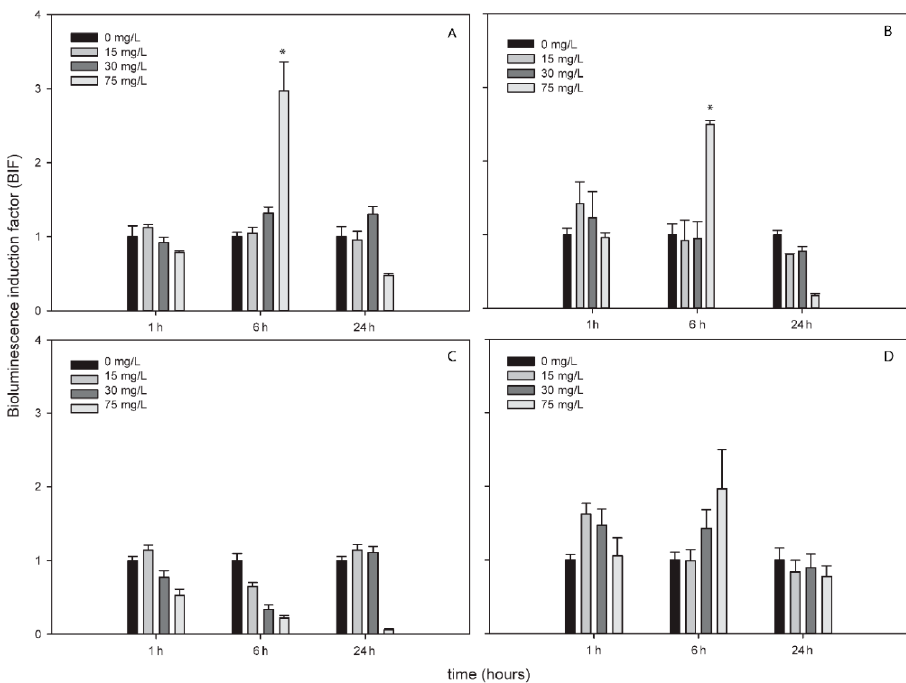
Figure 3 . Bioluminescence induction of ROS-detecting Nostoc sp PCC7120 bioreporters exposed to 0, 15, 30 and 75 mg/L of TiNPs after 1, 6 and 24 h of exposure. ( A ) Nostoc sp. PCC7120 pBG2154, ( B ) Nostoc sp. PCC7120 pBG2165, ( C ) Nostoc sp. PCC7120 pBG2172 and ( D ) Nostoc sp. PCC7120 pBG2173.